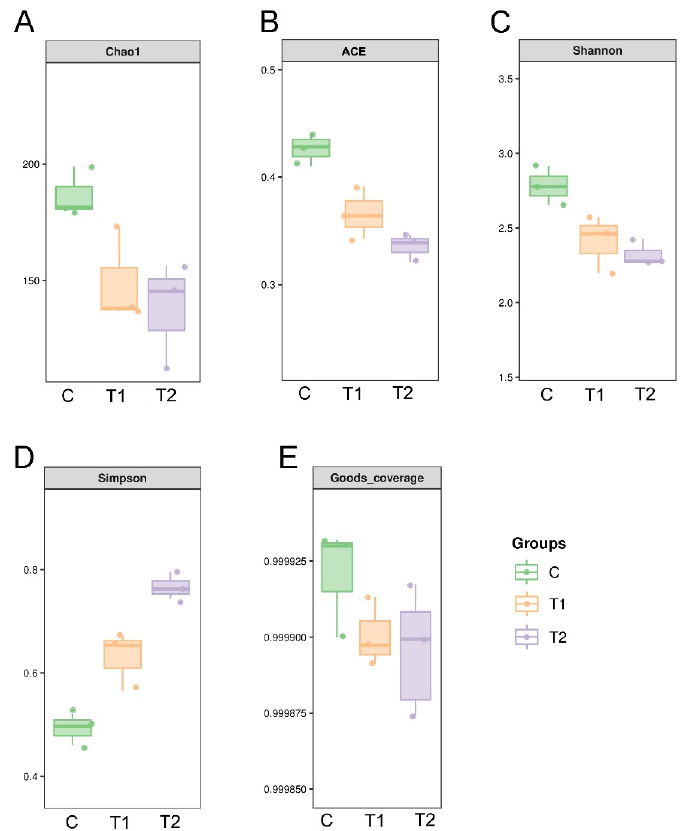
Figure 5. Richness and diversity indices of bacterial communities in different treatment groups of gibel carp exposed to aflatoxin B1 for 28 days. ( A ) Chao1 index, ( B ) abundance-based coverage estimator (ACE), ( C ) Shannon index, and ( D ) Simpson index of operational taxonomic unit (OTU) level. ( E ) The average Good’s coverage of treatment groups. C: control diet, T1: 50 µg/kg AFB1, T2: 100 µg/kg AFB1.